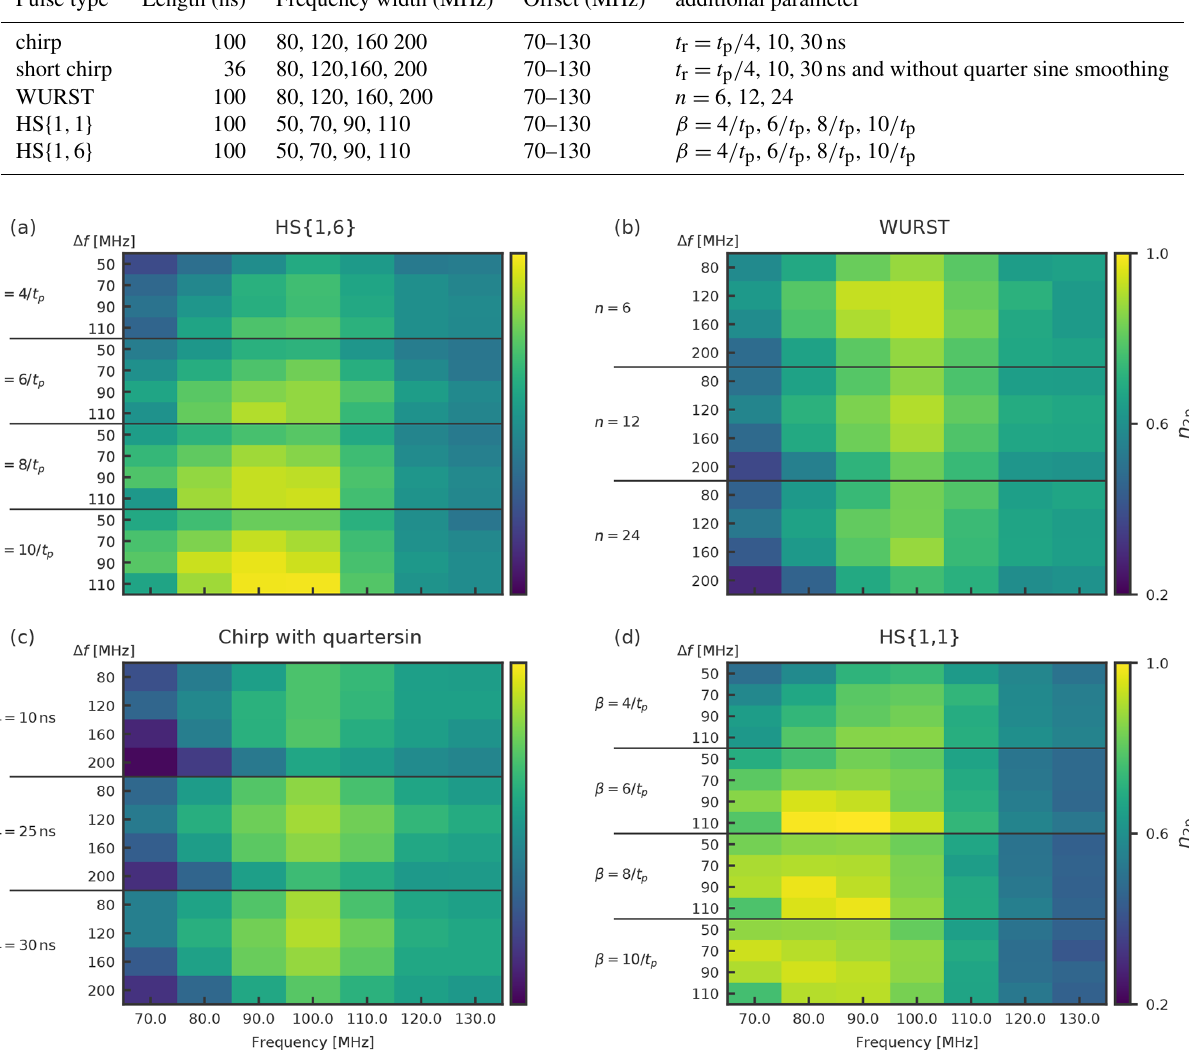
Figure 5. Heat maps with the η 2 P values for 4p-DEER measurements with an observer pulse length of 56ns, Gaussian pulses and an integration window of 56ns. The observer frequency is at 33.93GHz. The pump pulse length is 100ns. Each heat map shows a different pump pulse type: (a) HS { 1 , 6 } , (b) WURST, (c) chirp with quarter sine, and (d) HS { 1 , 1 }